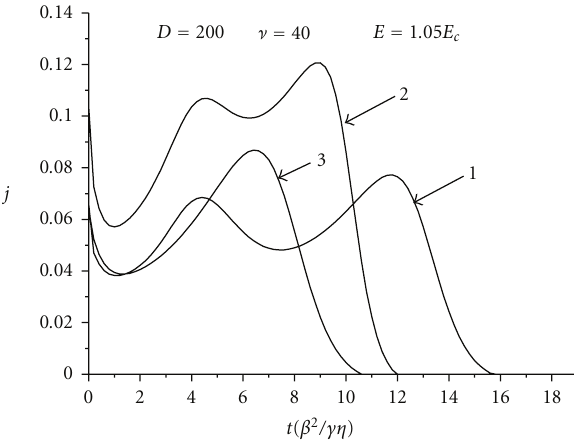
Figure 2: Switching rate, 1/ τ (in units of β 2 / ( γη )), from the metastable state to the stable state for the 2D system as a function of the dimensionless applied electric field E/E c ; E c is the coercive field. The number of dipoles is N = 64 × 64. The initial state corresponds to the ferroelectric state with a nucleus of the domain of the paraelectric phase (the size of the nucleus is 4 × 4) for δ = 1 . 330 (curve 1) and vice versa for δ = 0 . 7407 (curve 2). The calculations are carried out using D = 200, ν = 40. These coe ffi cients are taken from the dielectric and structure measurements in BaTiO 3 [17].